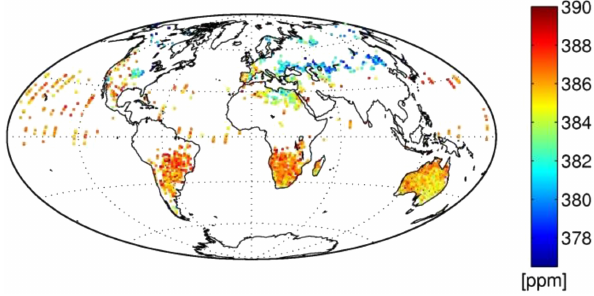
Figure 1. ACOS v3.4 release 3 XCO 2 Level 2 data (“observations”) for 2–7 August